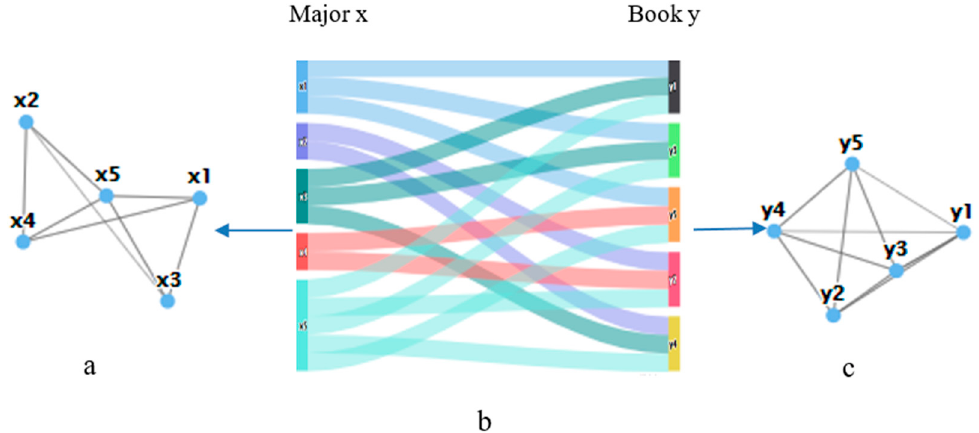
Figure 1. ( a ) Unit diagram for majors; ( b ) Bipartite graph of Majors and Books; ( c ) Unit diagram for books.